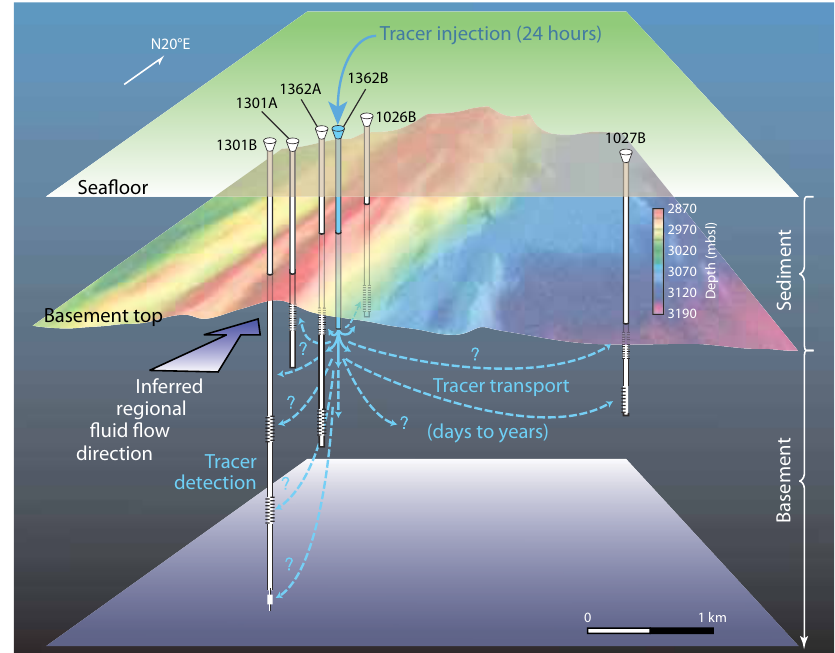
figure 5.6. multidisciplinary experiments using networks of subseafloor observatories include cross-hole hydrogeologic testing and injection of multiple tracers from a central borehole, with pressure and temperature monitoring and fluid sampling in surrounding boreholes distributed in multiple directions and distances. samples and data will be collected during active system pertur- bation using the drillship, and during subsequent years using long-term borehole observatories serviced with submersibles and remotely operated vehicles. The nature of cross-hole, multidirec- tional response provides critical information on subseafloor fluid pathways, natural patterns of circulation, and coupling among fluid, thermal, chemical, and biological components of the crustal system from fisher et al.,